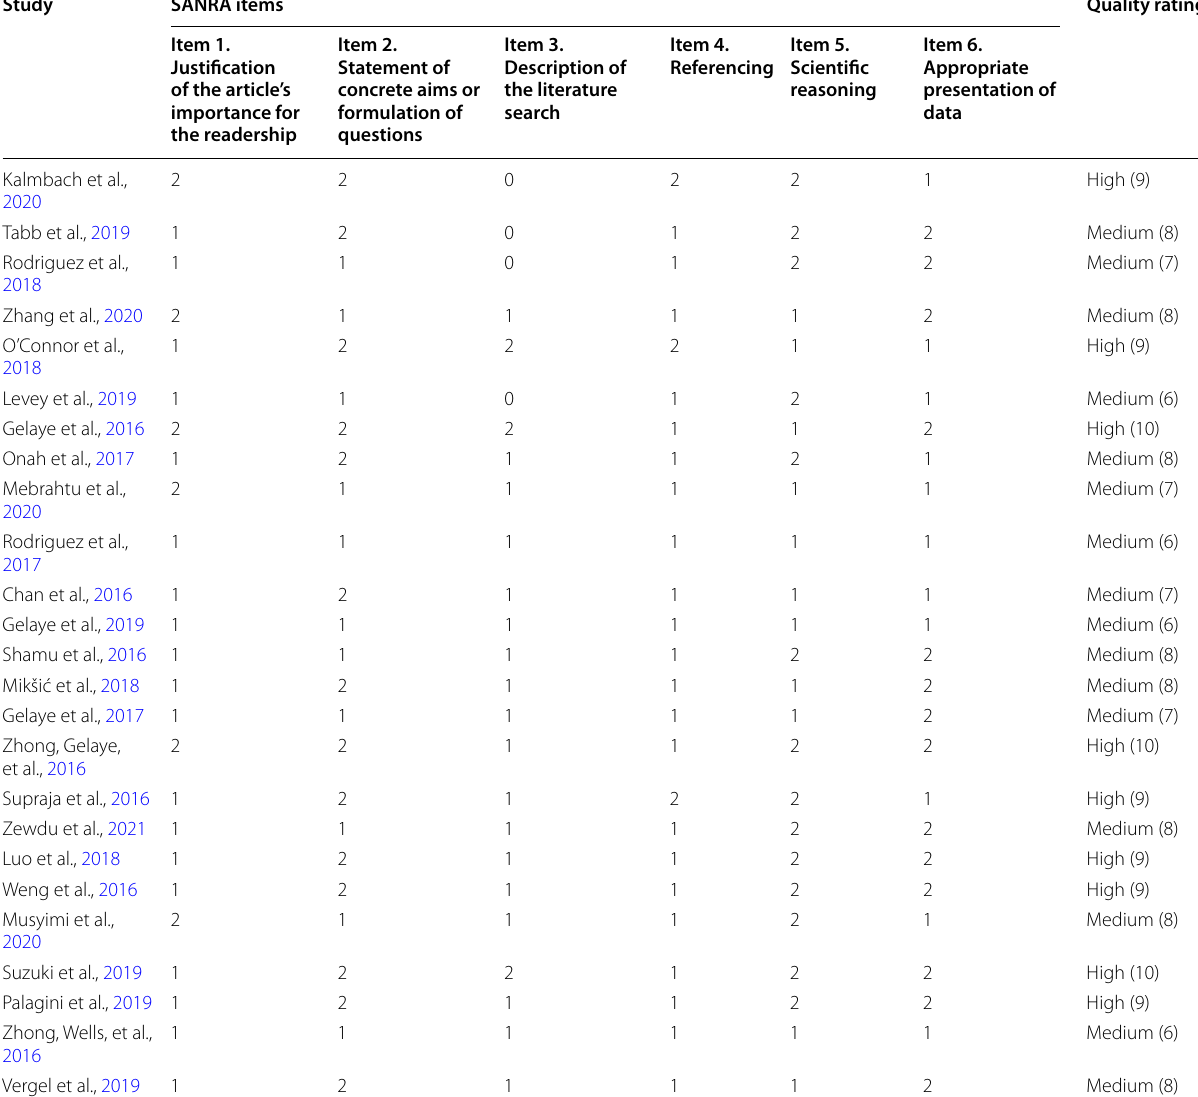
Table 2 Risk of bias of included articles in the narrative